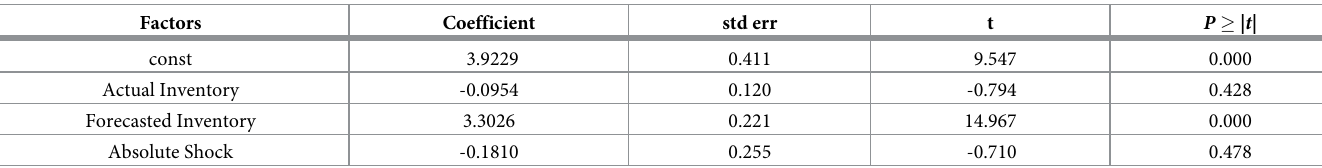
Table 4. Regression values of crude oil variance with forecasted inventory, actual inventory, and absolute shock.